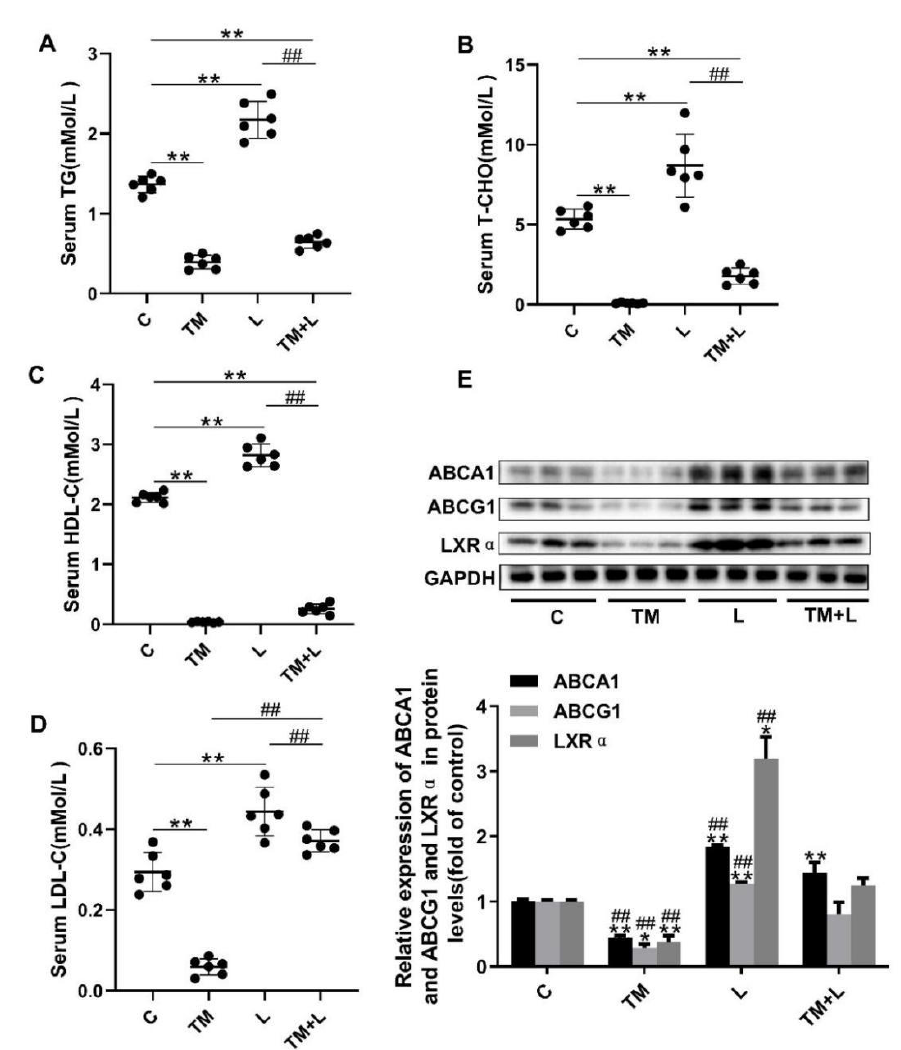
Figure 3. LXR-623 inhibited the e ff ect of ER stress on hepatic lipid e ffl ux. ( A ) Serum triglyceride levels. ( B ) Serum total cholesterol level. ( C ) Serum high-density lipoprotein (HDL) cholesterol level. ( D ) Serum low-density lipoprotein (LDL) cholesterol level. ( E ) Expression levels of ABCA1, ABCG1 and LXR α in the liver. C, control; TM, tunicamycin; L, LXR-623; TM + L, tunicamycin + LXR-623. Data are shown as the mean ± SD ( n = 6), * p < 0.05 or ** p < 0.001 versus the C group. ## p < 0.001 versus the TM + L